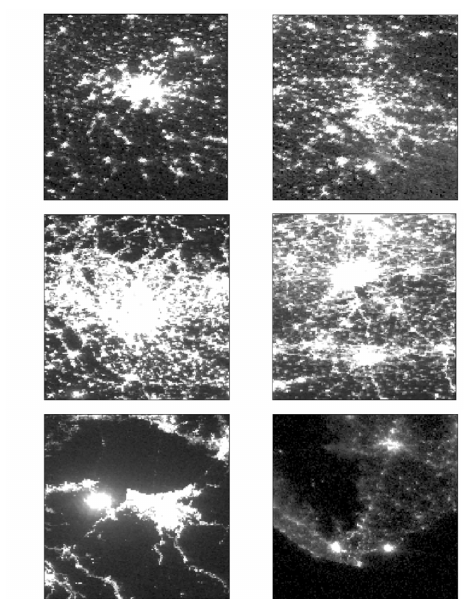
Figure 2. Cloud- & Moon-illumination-free ex. of Munich (top left), Stuttgart (top right), Milan (middle left), Brussels (middle right), New Orleans (bottom left) & Nagercoil (bottom right)